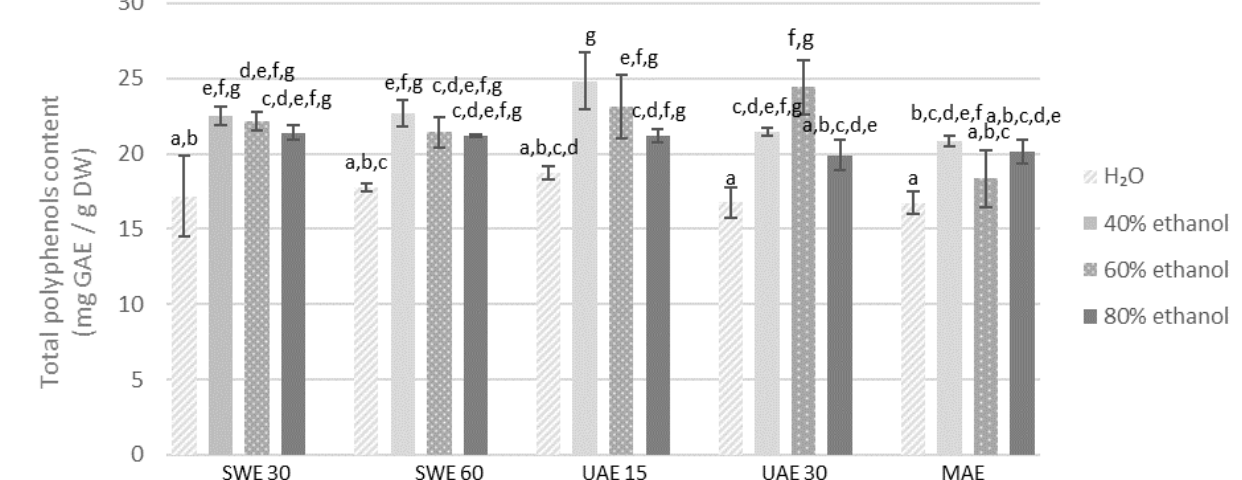
Figure 1. Polyphenols content in the extracts obtained from the fraction with particle size ≤ 0.5 mm. SWE—shaking water bath extraction; UAE—ultrasound-assisted extraction; MAE—microwave assisted extraction; 15, 30 or 60-time of extraction. Results are presented as the mean ± SD from triplicate determinations. Different letters: a, b, c, d, e, f, g indicate that samples are significantly different. The letter “a” marks the lowest value. Higher values are marked with consecutive letters of the alphabet. Bars that share the same letter within the group are not significantly different according to Tukey’s HSD test at p > 0.05.